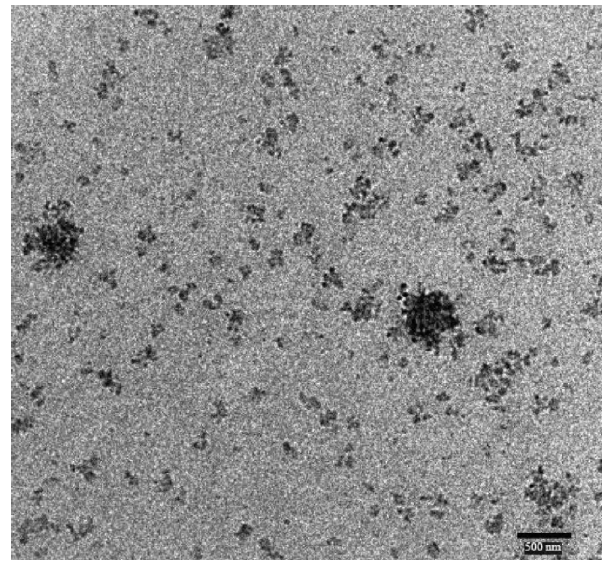
Figure 7. TEM image of flurbiprofen solid lipid nanoparticles. Reprinted from ref. [212] under the terms of the BioMed Central Open Access